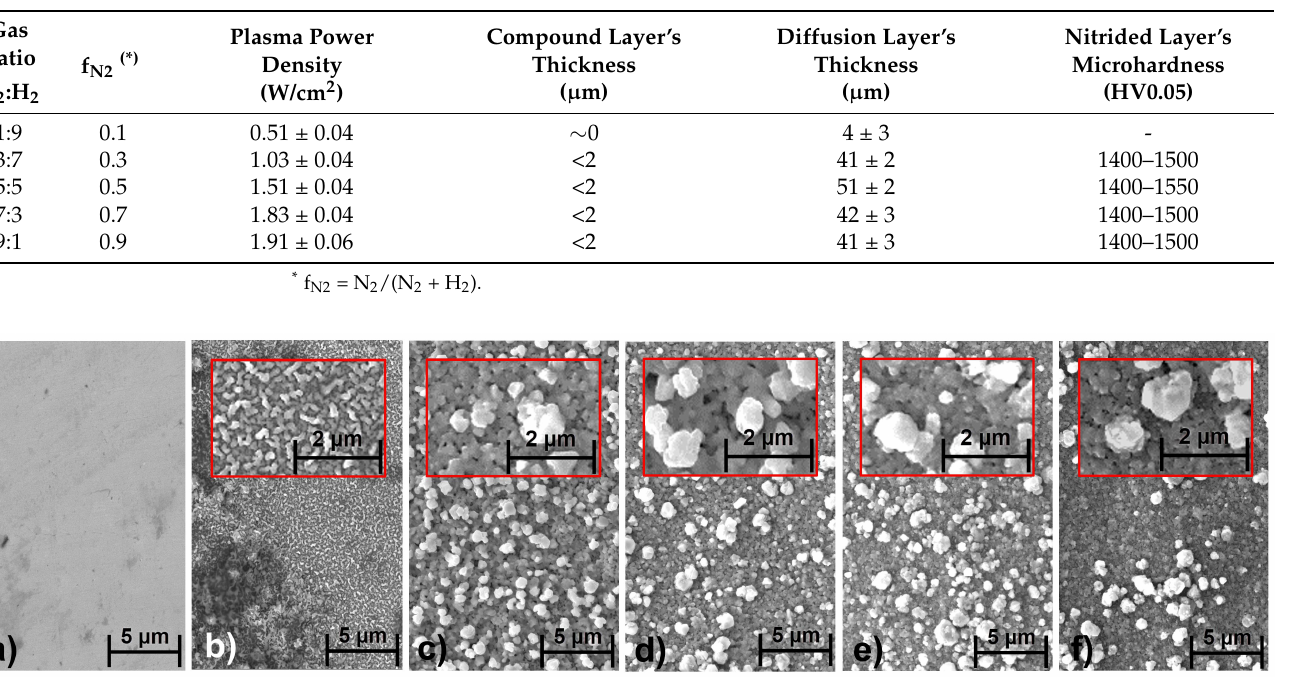
Figure 2. Cross-sectional image (SEM) of FeAl nitrided layer features, 575 ◦ C, 4 h, f N2 = 0.5. Table 1. Investigated conventional plasma nitriding parameters and initial characteristics of the nitrided layer.